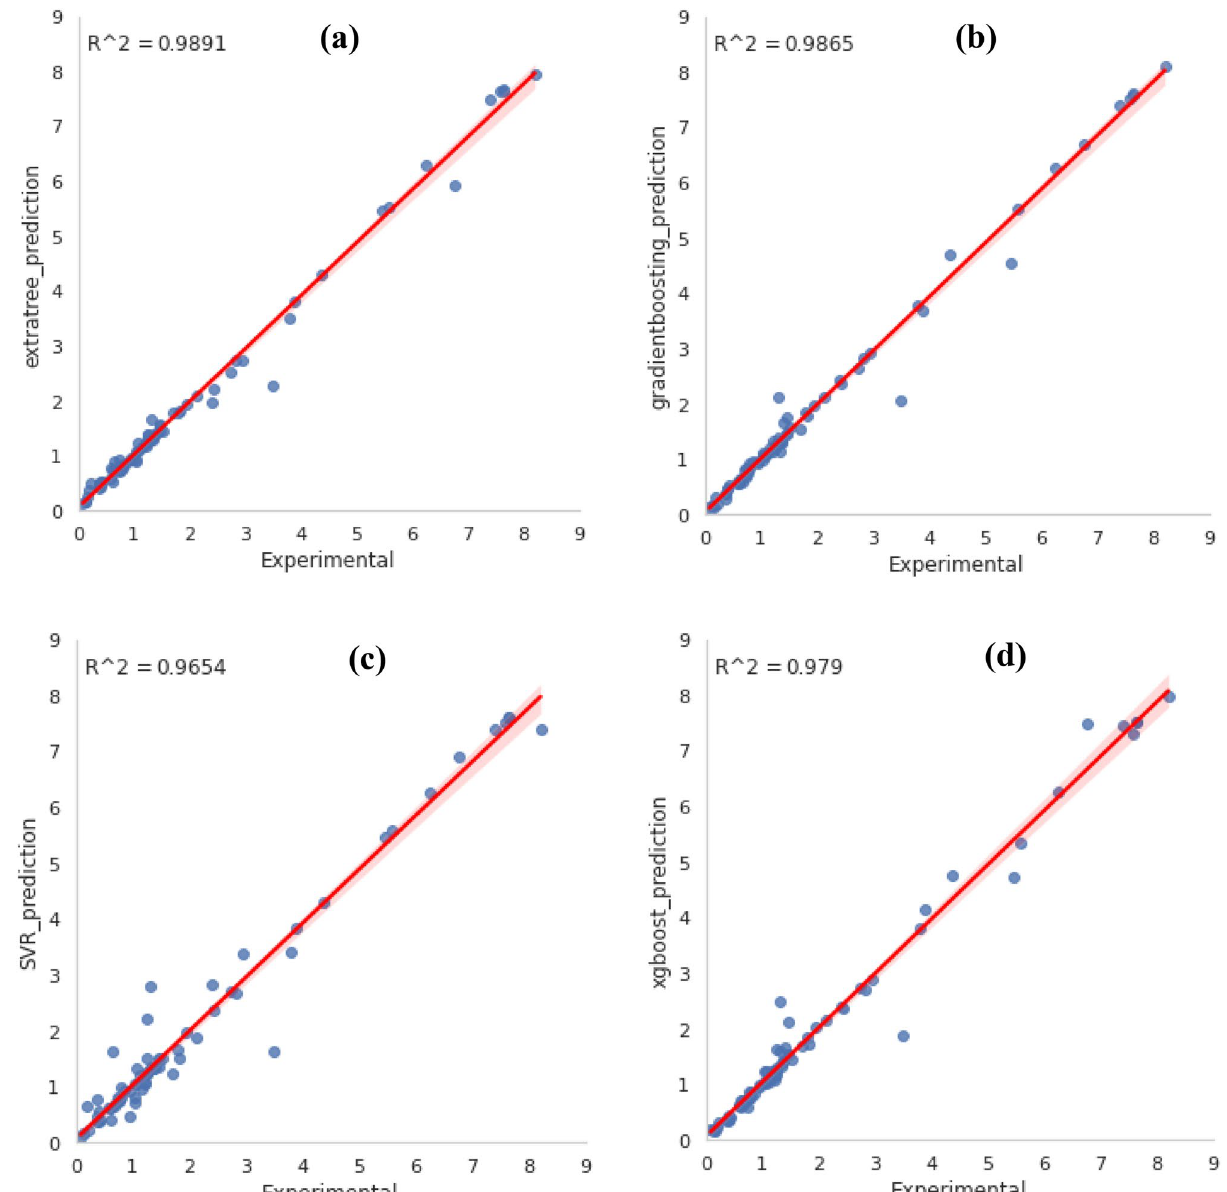
Figure 11. CO 2 adsorption experimental versus predicted data using the models: ( a ) Extratree, ( b ) Gradientboosting, ( c ) SVM, ( d ) Extragradient boosting, ( e ) Randomforest, ( f ) ANN-MLP, and ( g )